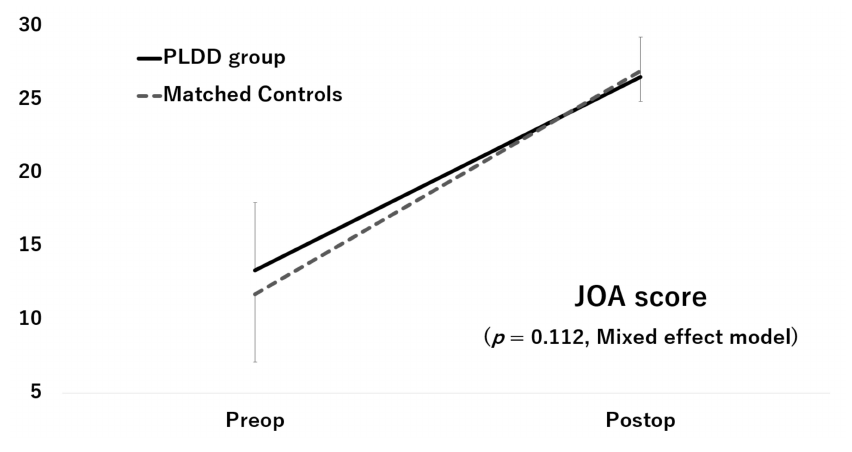
Figure 2. Improvement of the JOA score.